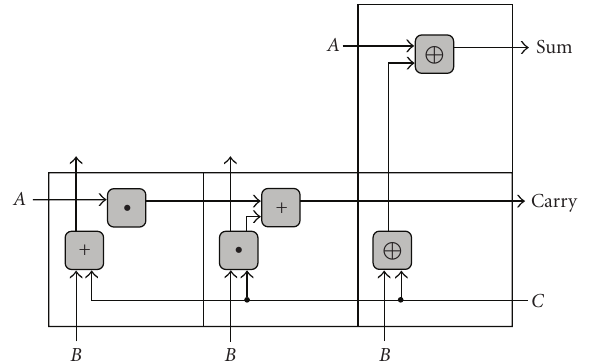
Figure 13: Full adder constructed from four cells in a PQ-cell array.